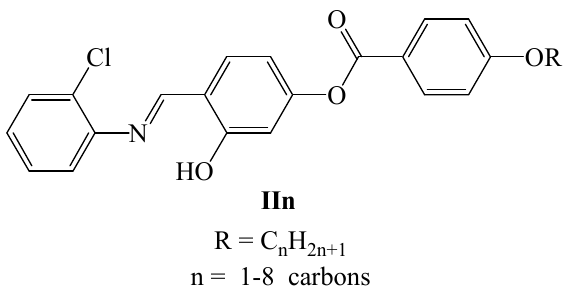
Figure 4. Conjugation of molecules , In